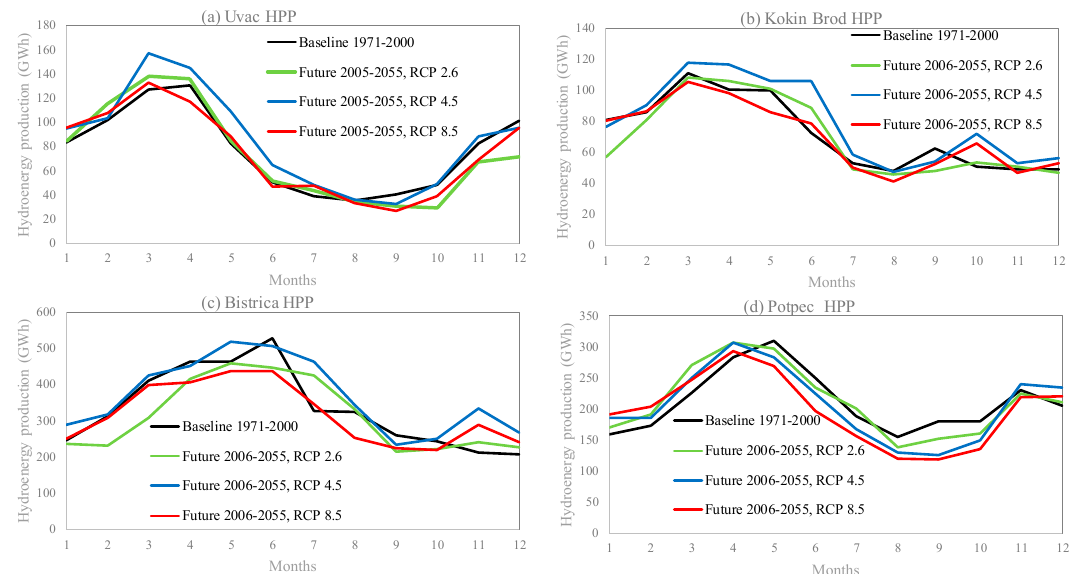
Figure 8. Seasonal distribution of the hydropower generation (gigawatt hours (GWh)) for the hydropower plants (HPPs) of the Lim water system: Bold line—baseline period 1971–2000, thin lines—future period 2006–2055 under RCP 2.6, RCP 4.5, RCP 8.5. (( a ) Uvac HPP, ( b ) Kokin Brod HPP, ( c ) Bistrica HPP, ( d ) Potpec HPP).